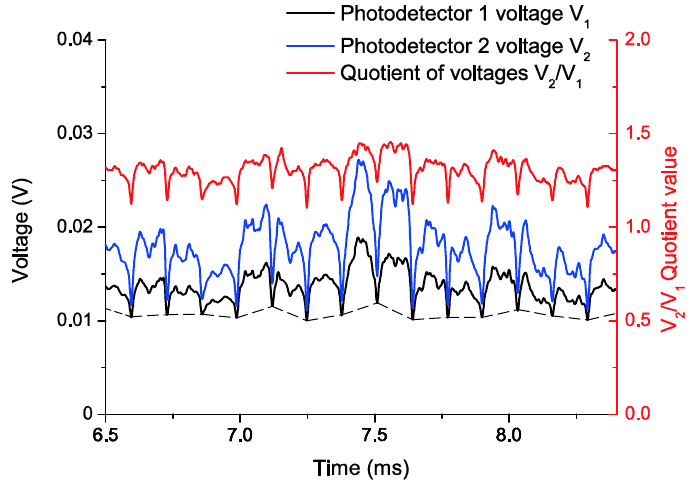
Figure 10. Filtered signals from the photodetectors and their quotient at a working point of 3,148